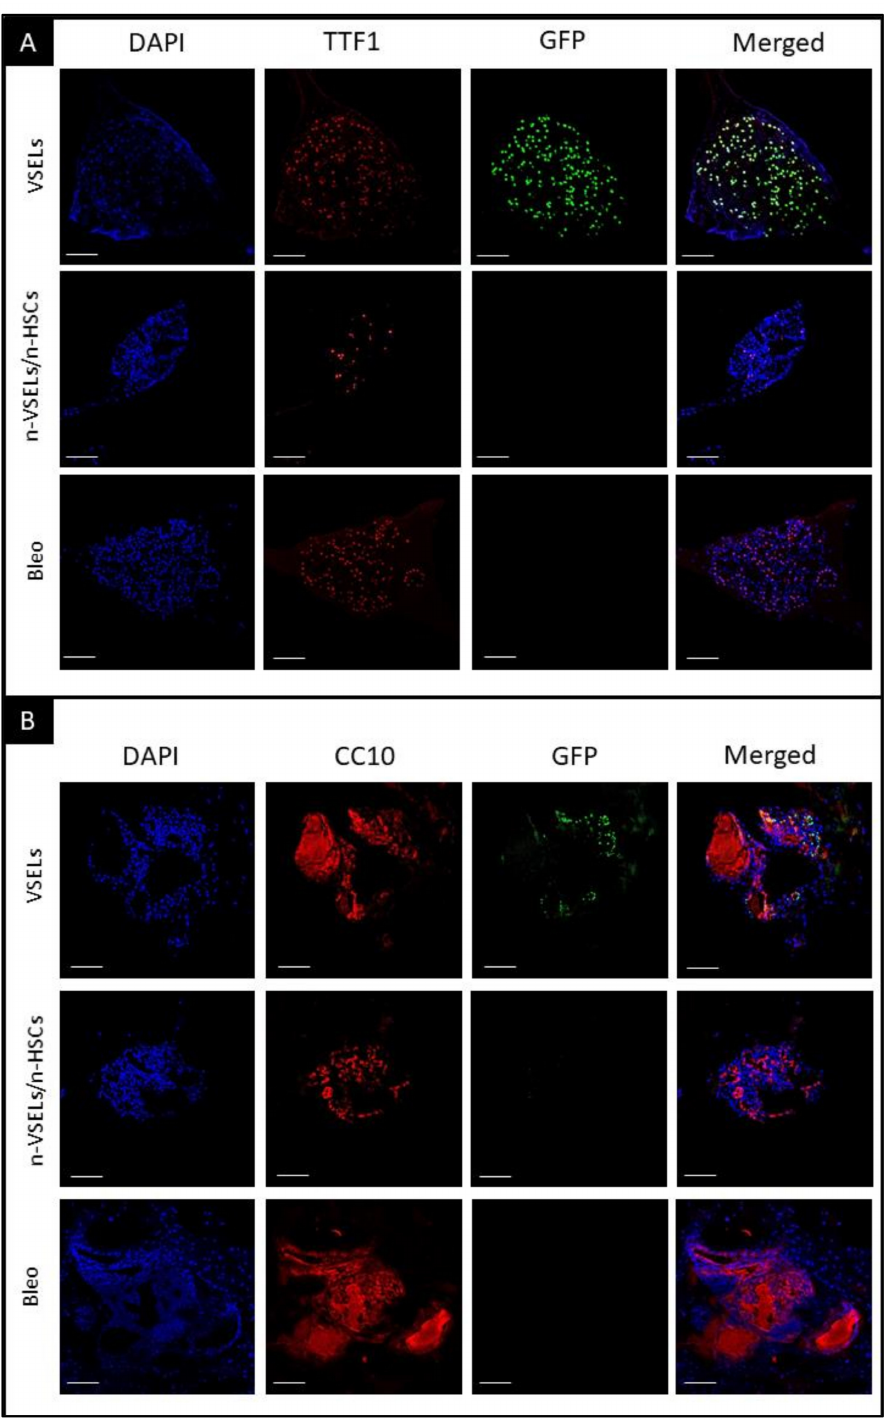
Figure 7. Detection of airway epithelia and AT2 cells in organoids. Immunofluorescent staining of representative organoid sections from each of transplant groups as indicated. Scale bars represent 100 µ m. Panel A : blue—DAPI, red—TTF1, green—GFP, and merged. Colocalization of DAPI, GFP, and TTF1 indicates donor VSEL derived AT2 cells, representing maintenance of proliferation and differentiation; Panel B : blue—DAPI, red—CC10, green—GFP, and merged colors. Colocalization of DAPI, GFP and CC10 indicates that donor VSEL-derived BASCs self-renew and form organoids, which proves their full physiological abilities. Note that CC10 + cells are GFP − , as GFP is expressed from the SPC promoter. CC10 is cytoplasmic and secretory protein what can be observed in stained Matrigel (cell-free, no DAPI nuclei) in addition to individual